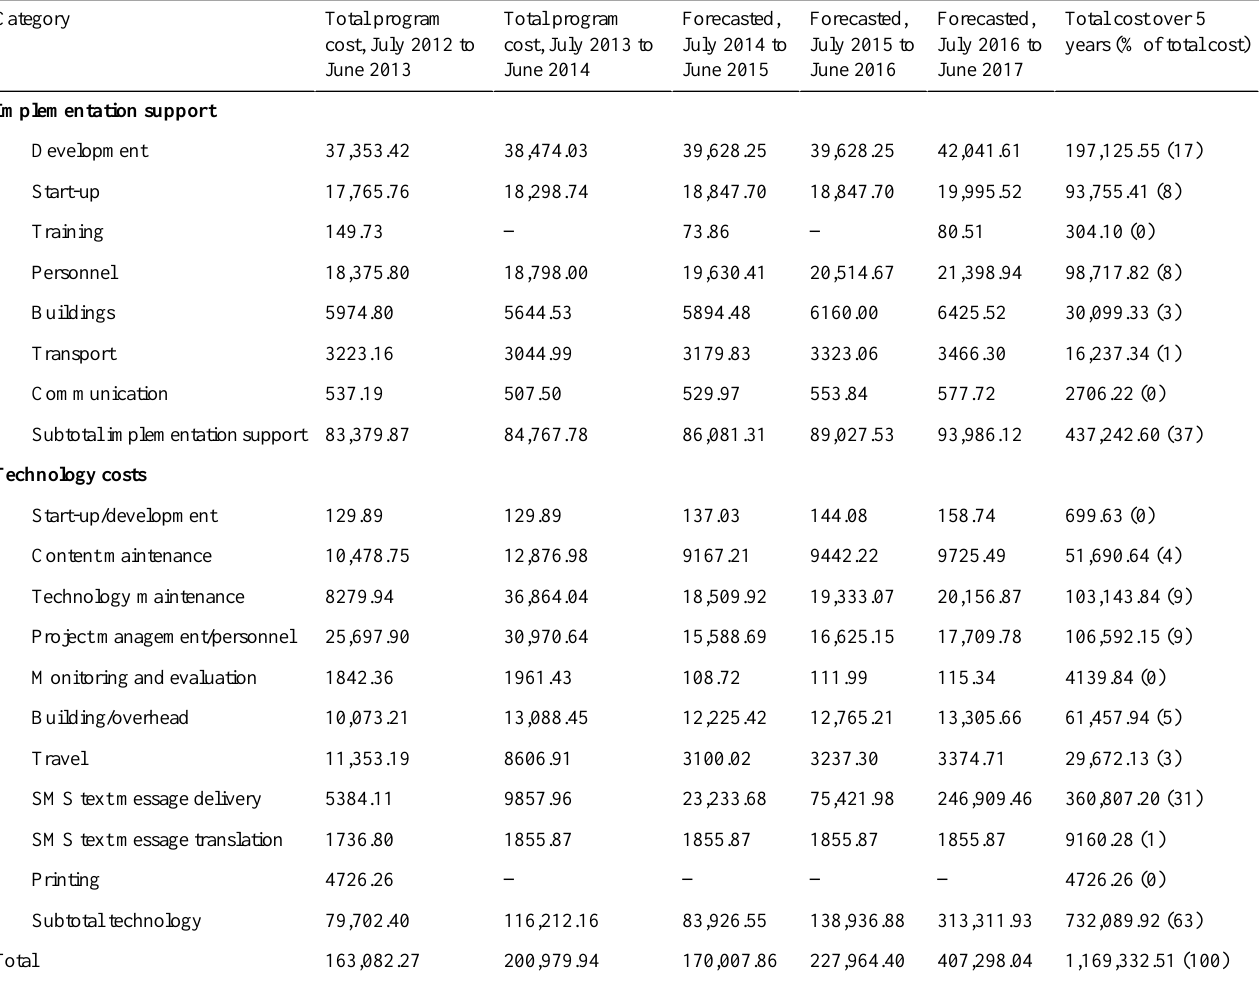
Table 1. Forecasted 5-year costs in 2015 US $ for gradual rollout in Gauteng province, South Africa.